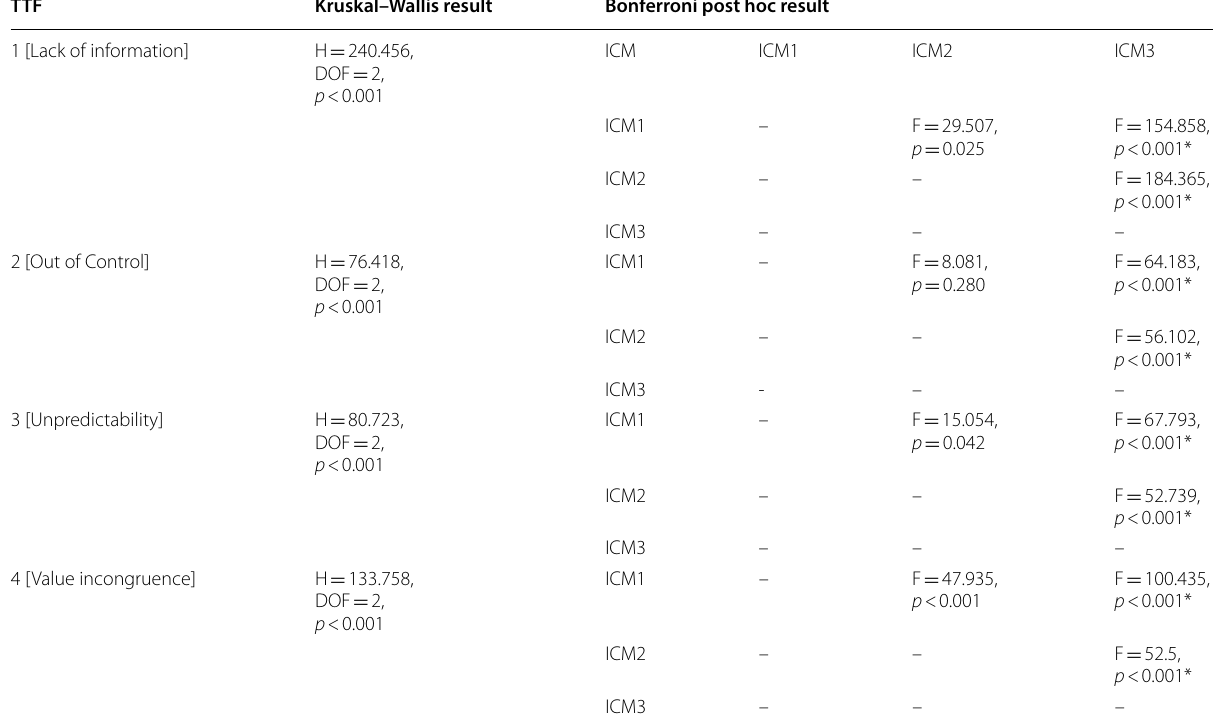
Table 6 Statistical result of information configuration methods according to TTFs